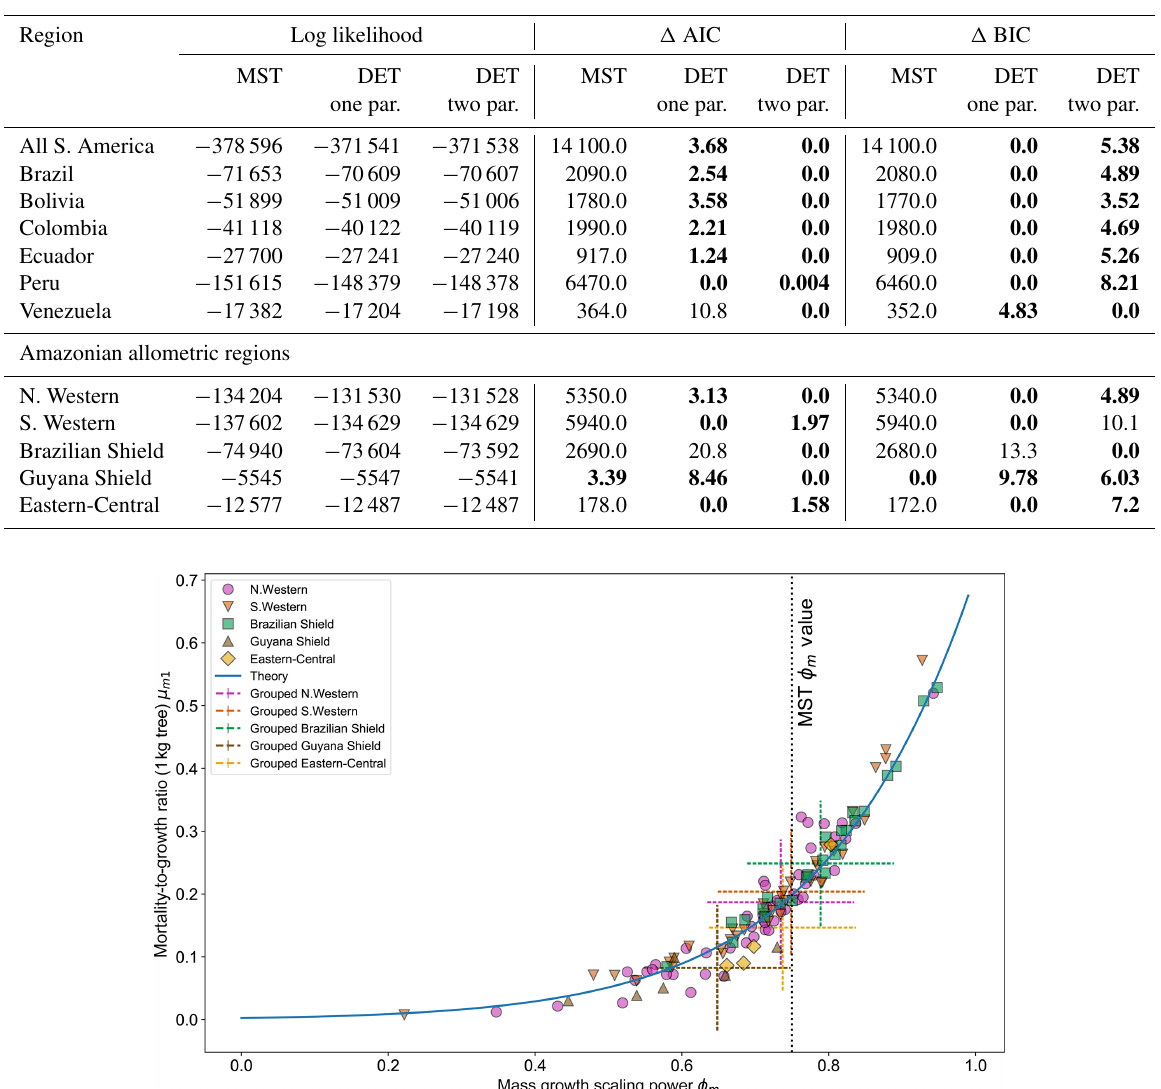
Figure 7. Results of the two-parameter DET-LTWD MLE fits for mass data from all 124 individual forest plots. The fitted mortality-to- growth ratio µ m1 , for each plot, is shown as a function of the fitted growth scaling power φ m . The results from the fits to the grouped datasets of the four allometric regions are plotted as the dashed crosses of corresponding colour. The vertical black line shows the φ m value predicted by MST allometry. The blue line represents the relationship derived from MLE equations for DET, showing the best fit µ m1 for a given φ m